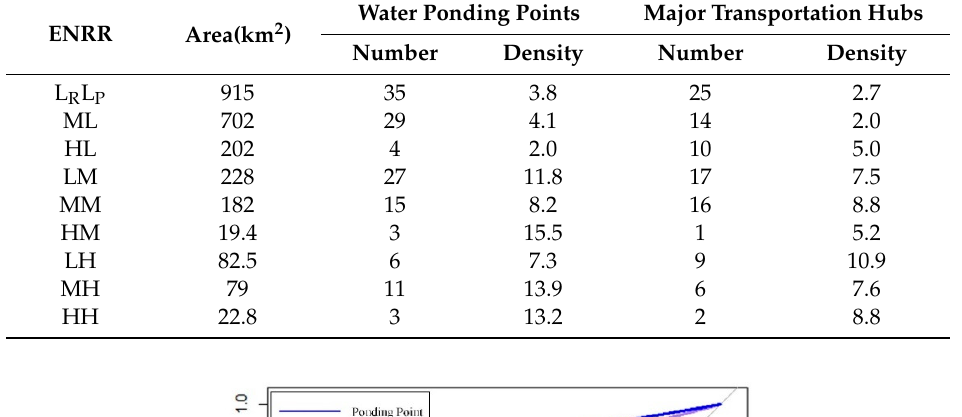
Table 2. The statistics of water ponding sites and transportation hubs by different ENRR categories.